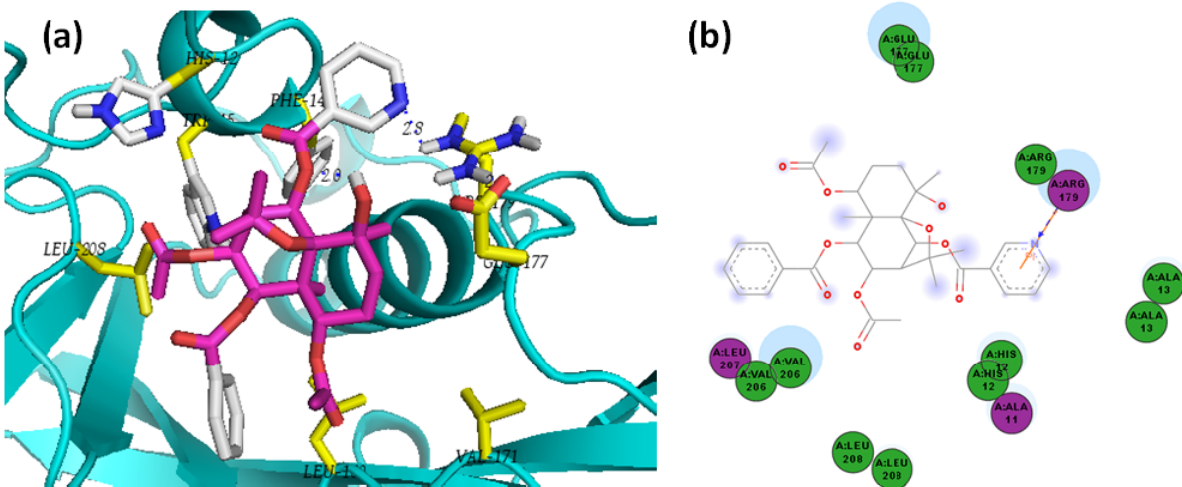
Interactions are represented as: van der Waals (green circle); polar (magenta circle); H -bond with amino acid side chains (blue dashed line); H -bond with amino acid backbone (green dashed line); pi interaction (orange